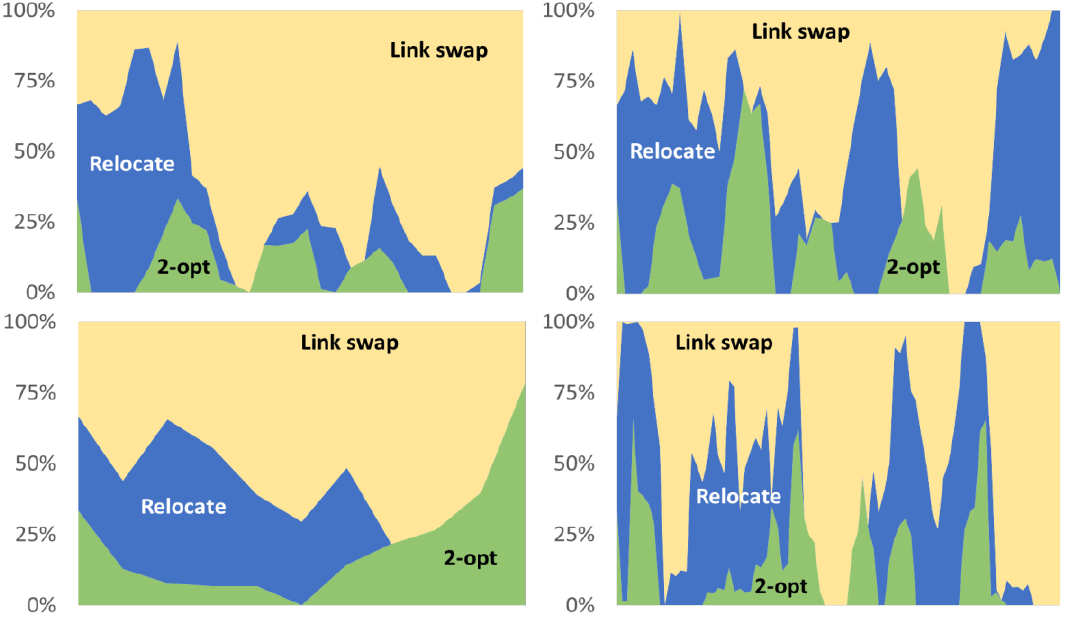
Figure 24. Productivity of the operators during the search with for 4 different Dots instances.